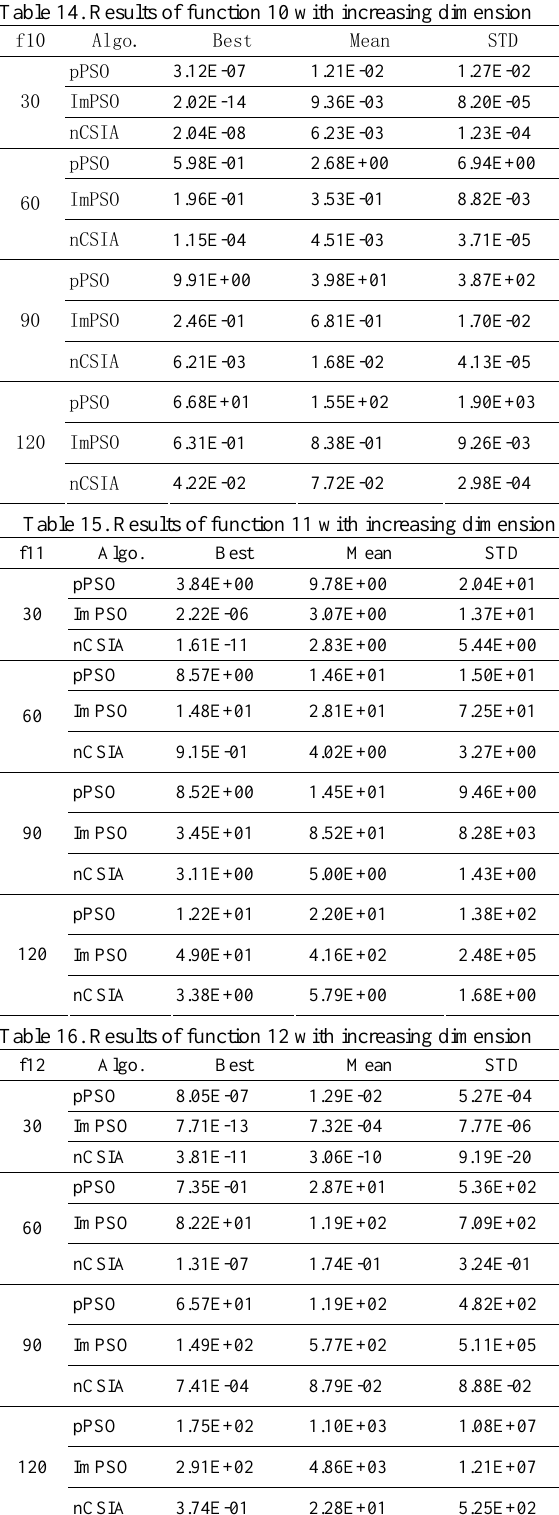
Table 14. Results of function 10 with increasing dimension f10 Algo.